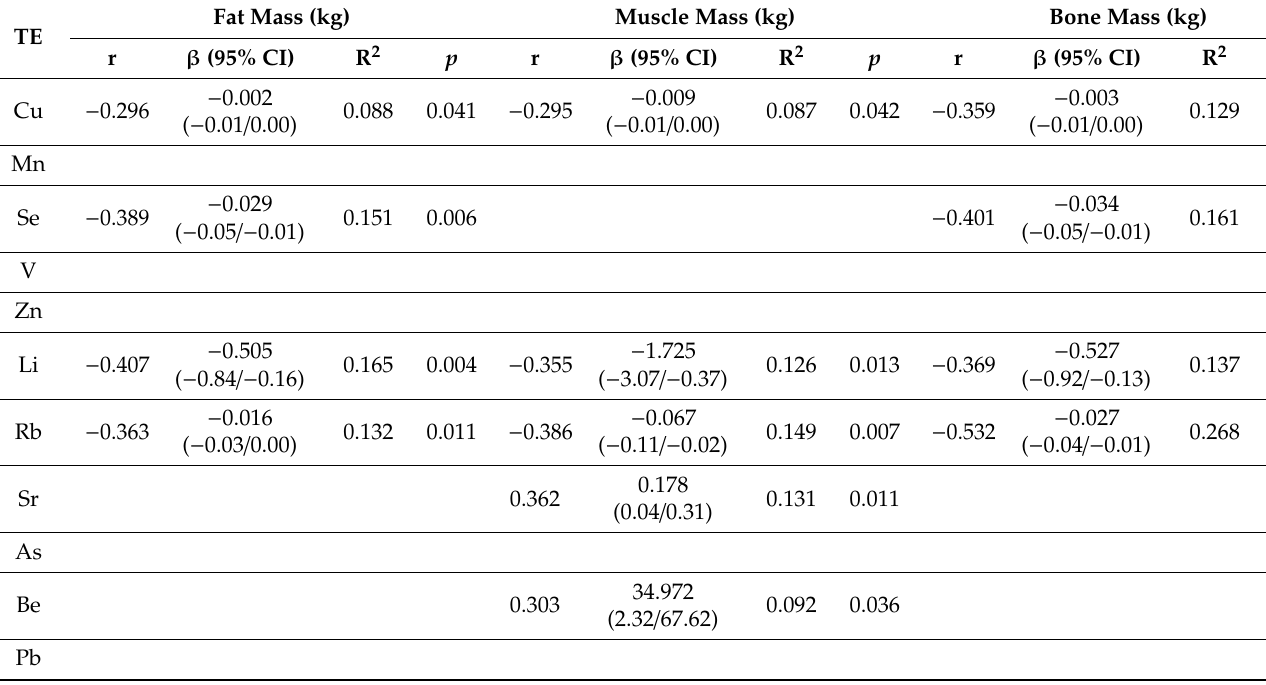
Table 6. Correlations between fat, muscle and bone mass with mineral trace elements in the